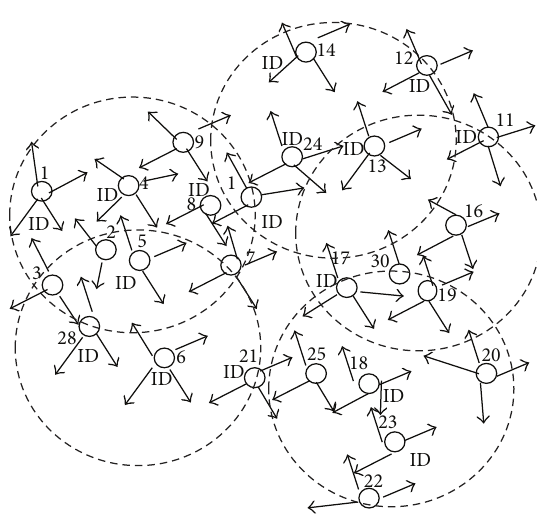
Figure 1: Initial example MANET.